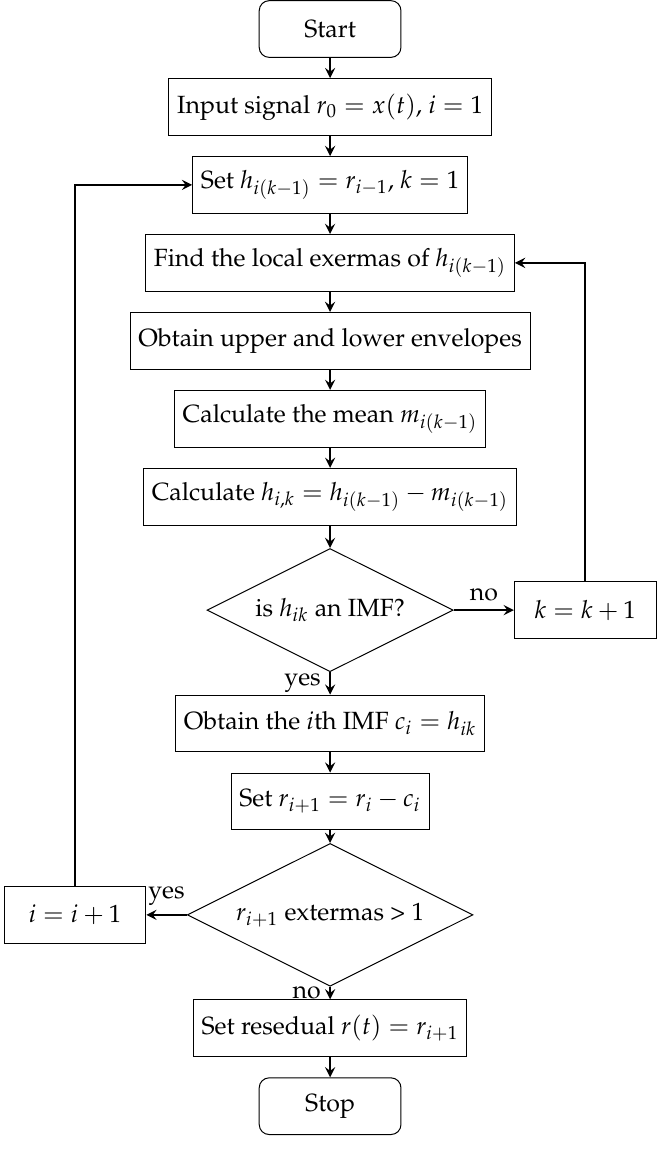
Figure 1. The procedure to obtain Intrinsic Mode Functions (IMFs) using Empirical Mode Decomposition (EMD) technique, adapted from [22]. Refer to the text for more